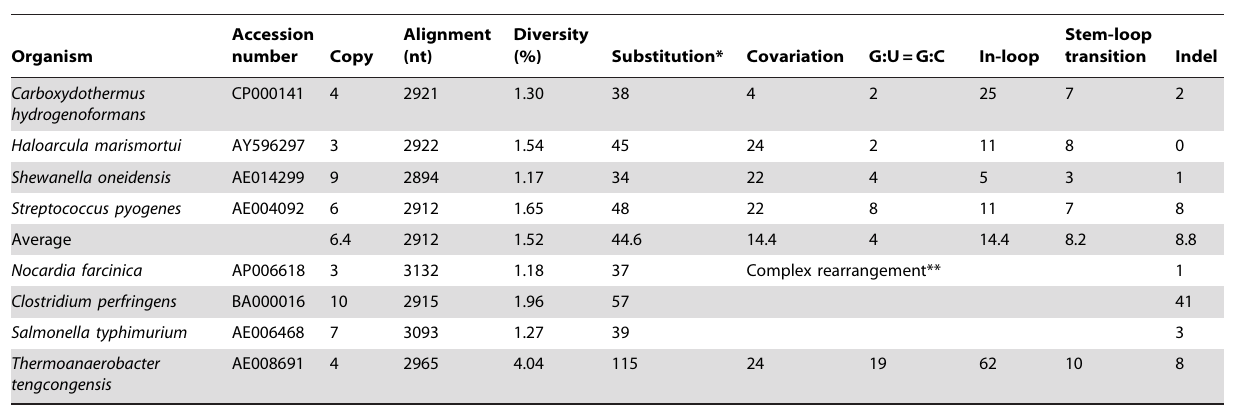
Table 1. Genomes with significant intragenomic diversity among paralogous 23S rRNA genes.